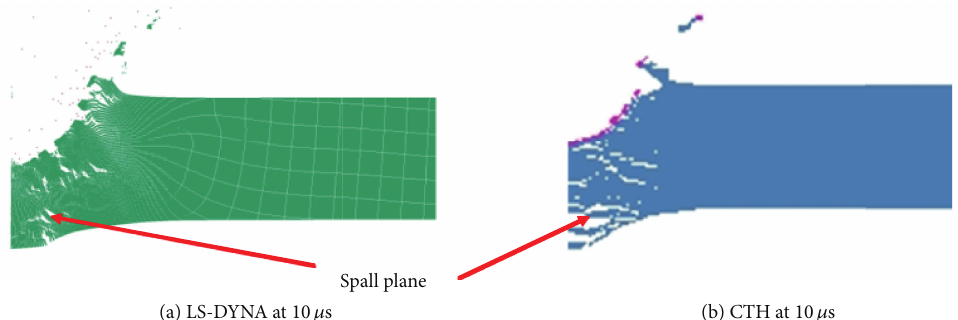
Figure 12: Spall plane in Test 1000-017 simulations.